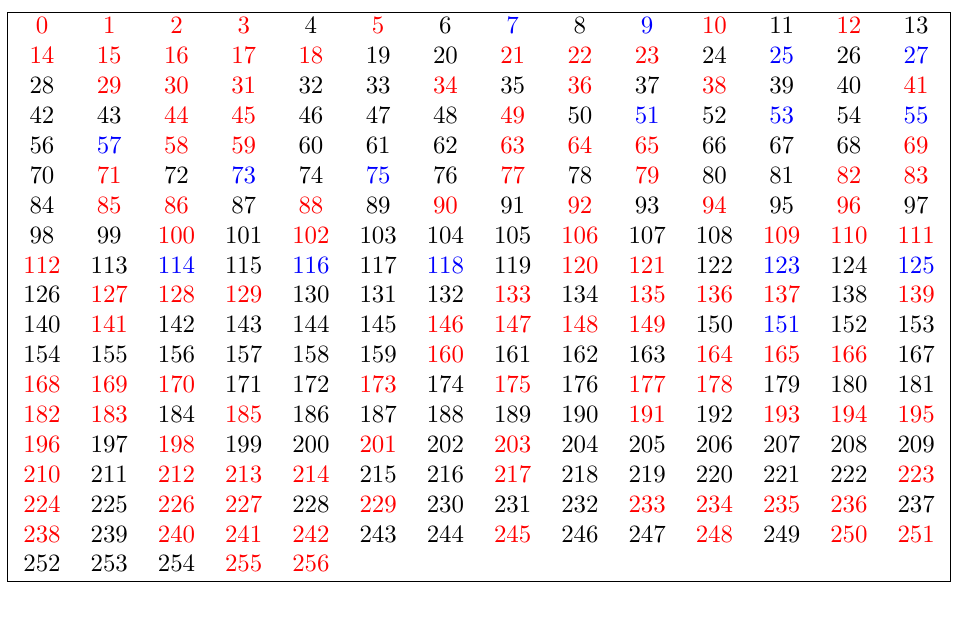
Table 4: Information of known bits, secret bits and guessed bits, where the known bits are marked in red, the guessed bits are marked in blue, and the secret bits are marked in